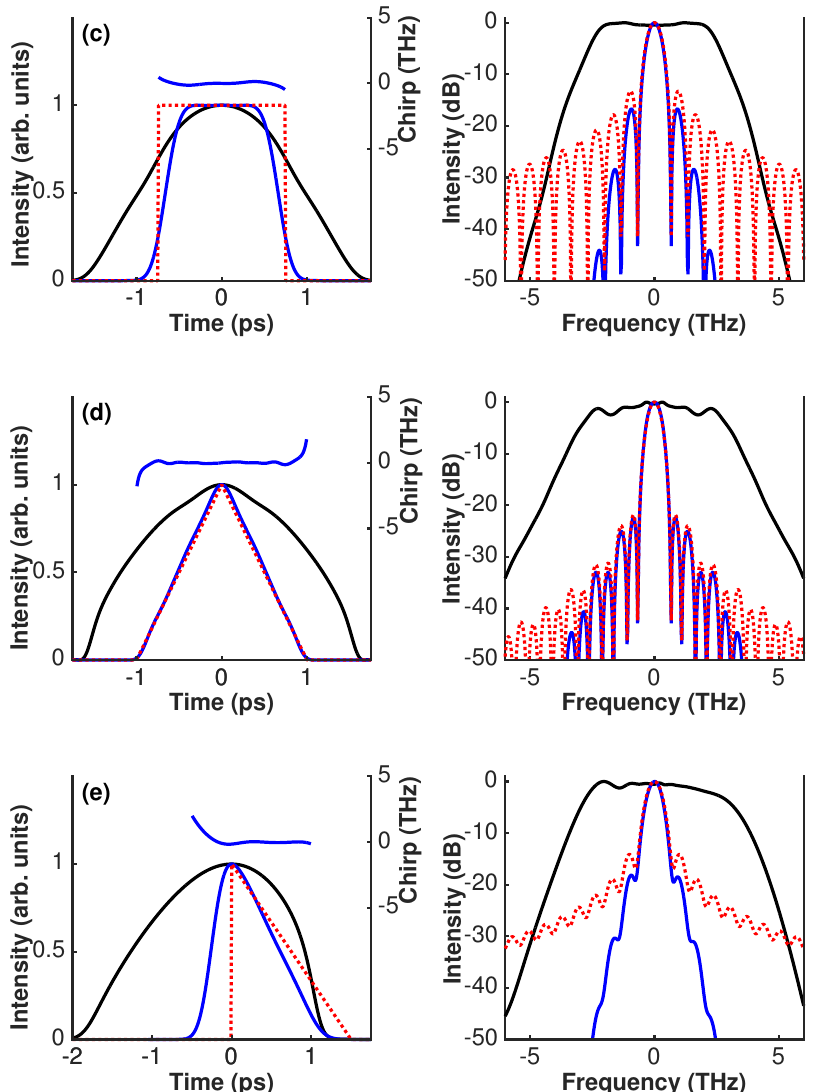
Figure 2. Temporal intensity and chirp profiles ( left ) and spectral intensity profiles ( right ) of the output pulse from the laser (blue) for a ( a ) bright parabolic, ( b ) dark parabolic, ( c ) flat-top, ( d ) triangular and ( e ) saw-tooth impulse response of the spectral pulse shaper. Also shown are the target profiles (red dotted) and the profiles at the exit of the gain fibre